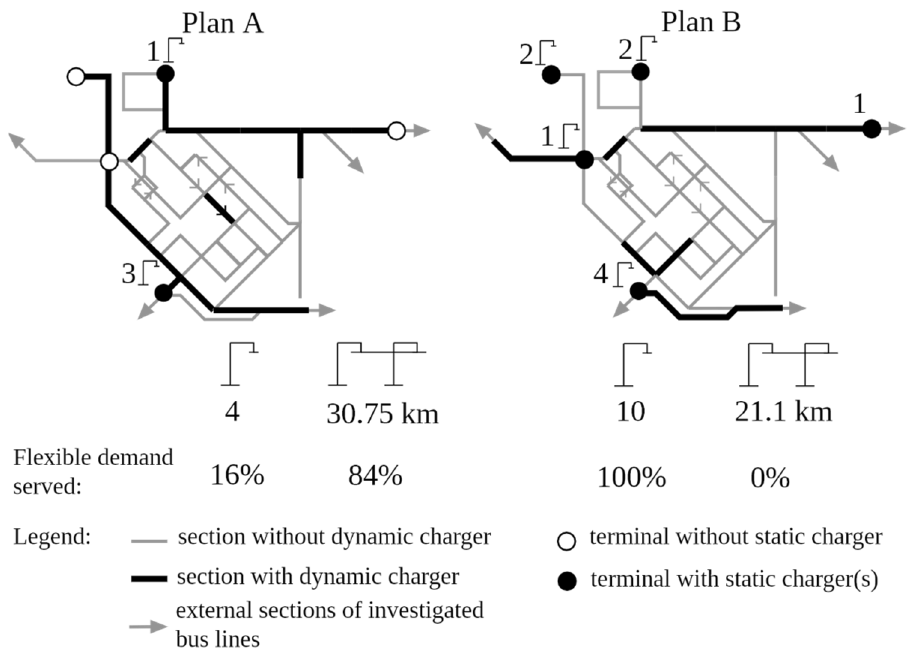
Figure 6. Optimum charging infrastructure plans in the case of no existing charging infrastructure.